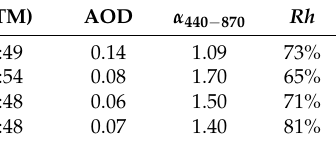
and time (UTM), and the associated atmospheric conditions (i.e., AOD, ff 440 − 870 and Rh ).